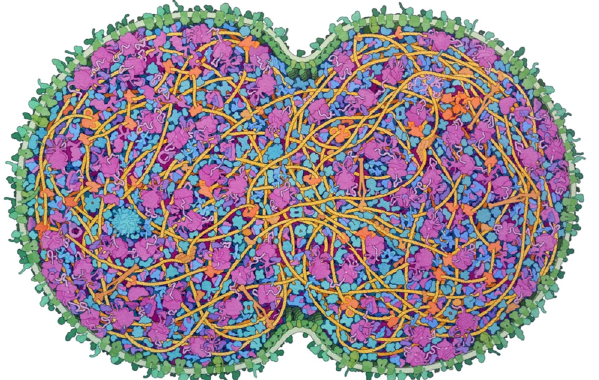
Figure2: IntegrativeillustrationofaJCVI-syn3Aminimal cell: the artistic conception of a cross-section through a dividing cell. Small molecules, ions, and water have been omitted for clarity ( © 2022 Goodsell, CC BY 4.0